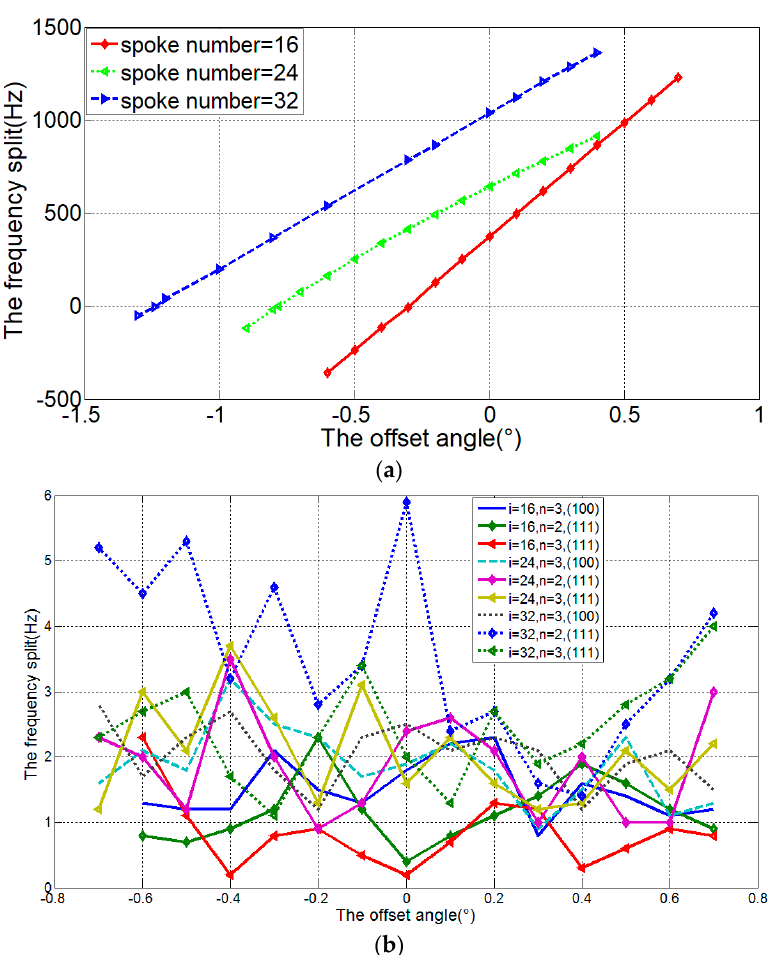
Figure 5. Relationship between the frequency splits and the varying spoke positions ( a ) DRG made by <100> silicon and work in n = 2 mode, ( b ) DRG made by <100> silicon and work in n = 3 mode; <111> silicon, work in n = 2 and n = 3 mode.